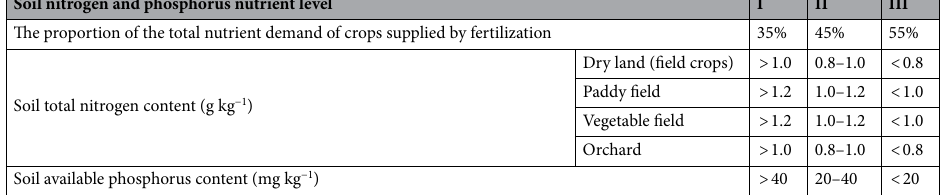
Table 3. Recommended ratio of fertilization and supply of nutrient under different soil nitrogen and phosphorus